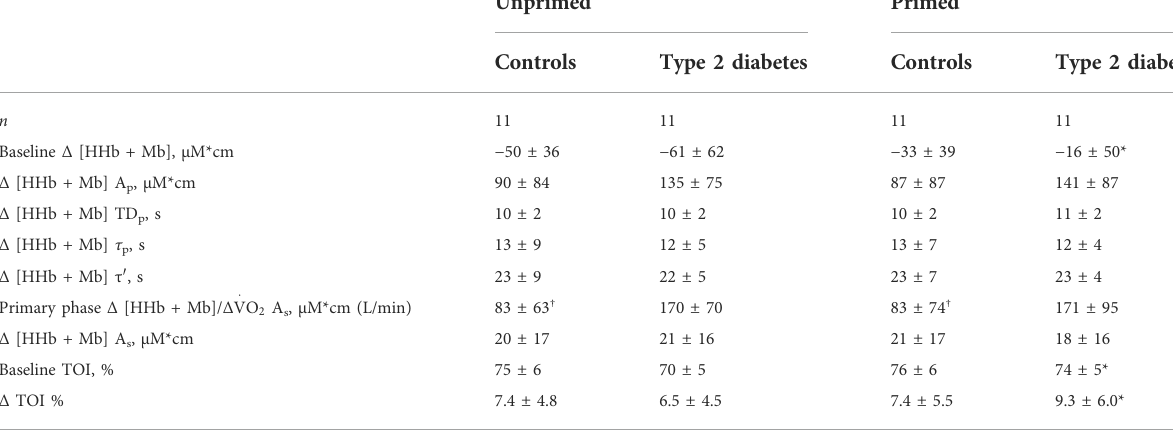
TABLE 3 Dynamic response characteristics of Δ [HHb + Mb] and TOI during high-intensity cycling exercise